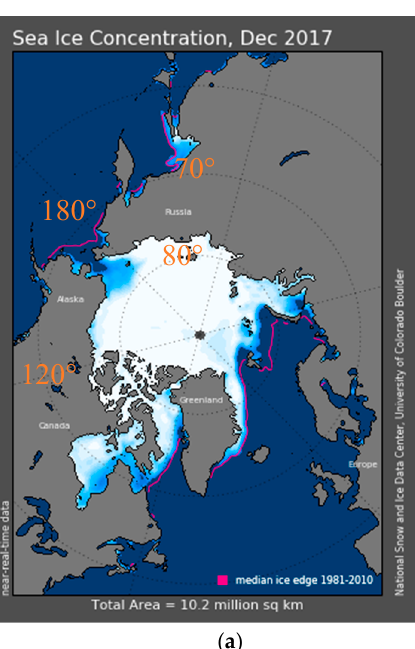
Remote Sens. 2019 , 11 , x FOR PEER REVIEW 18 of 27